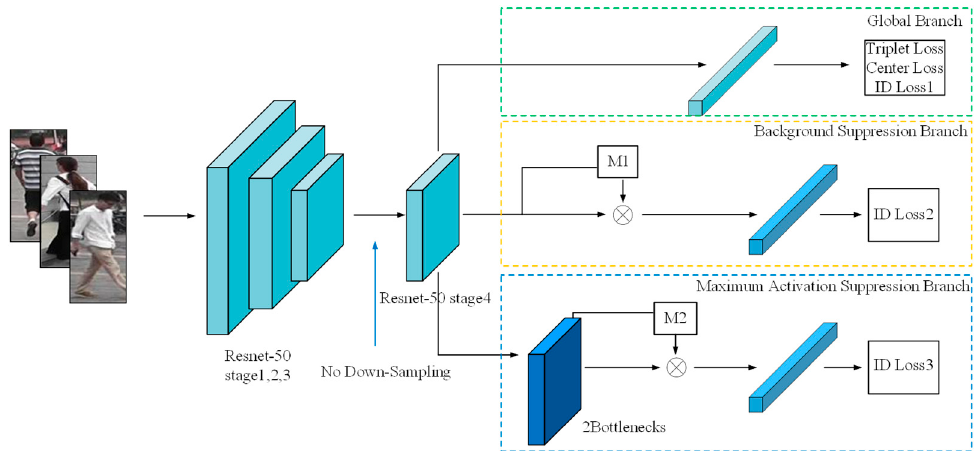
Figure 3. Proposed self ‐ erasing network with three branches. The convolution step of the final stage of the backbone network is changed from 2 to 1 to retain more image information. The global branch sends the feature vector after global average pooling to the triplet loss, center loss and ID loss. The background suppression branch and the maximum activation suppression branch, respectively, use global average pooling and global maximum pooling for spatial dimensionality reduction and use ID loss for supervision, where all the features using ID loss are normalized.